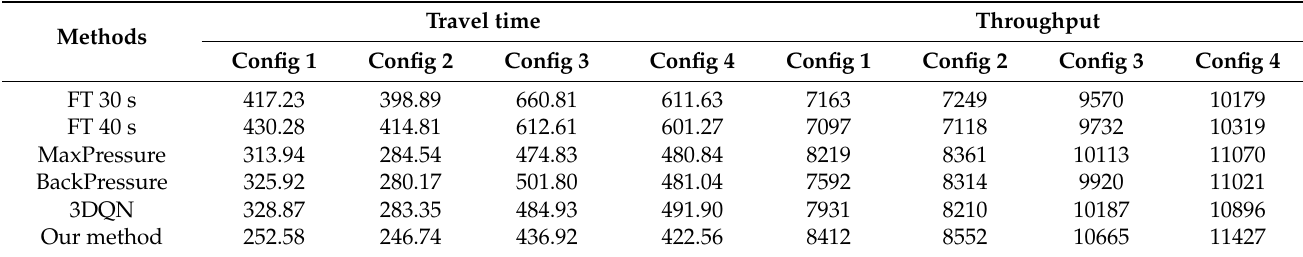
Table 5. Performance comparison of different methods on the RN 4 × 8 network.